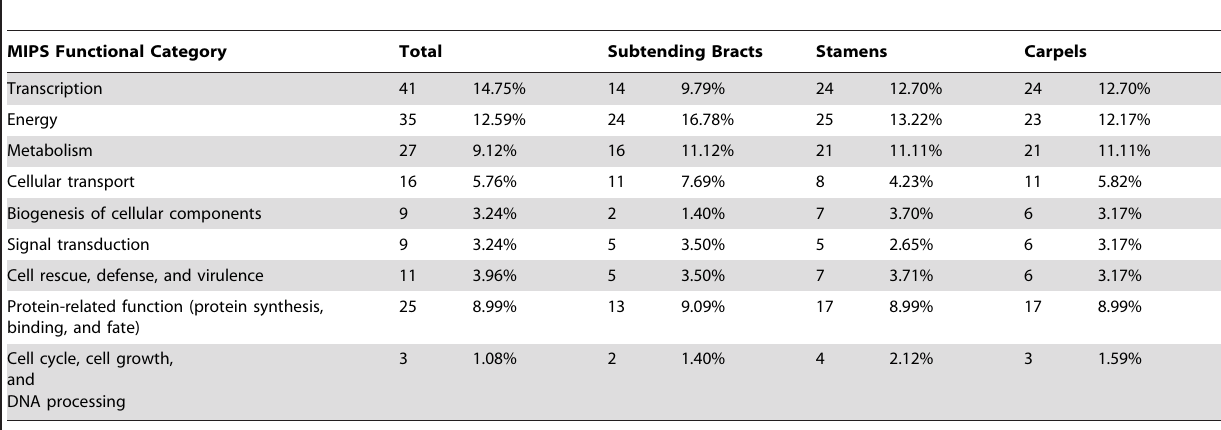
Table 1. MIPS Functional Category assignments of S. chinensis genes differentially expressed during inflorescence tissue development relative to seedling leaf development.